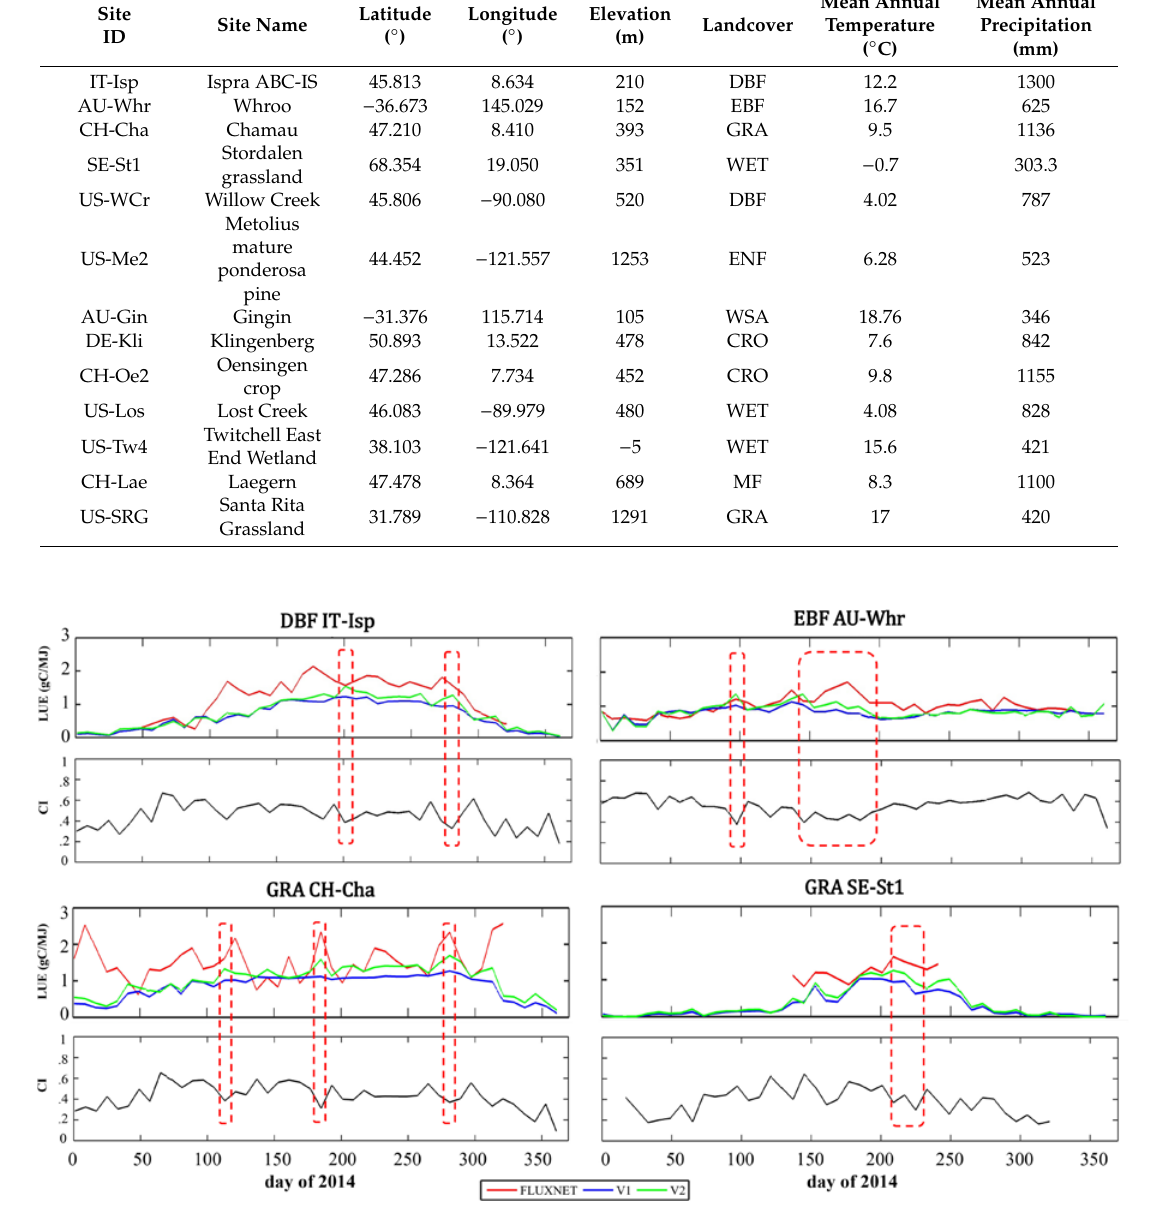
Figure 9. LUE and GPP curves in IT-Isp, AU-Whr, CH-Cha and SE-St1. 489